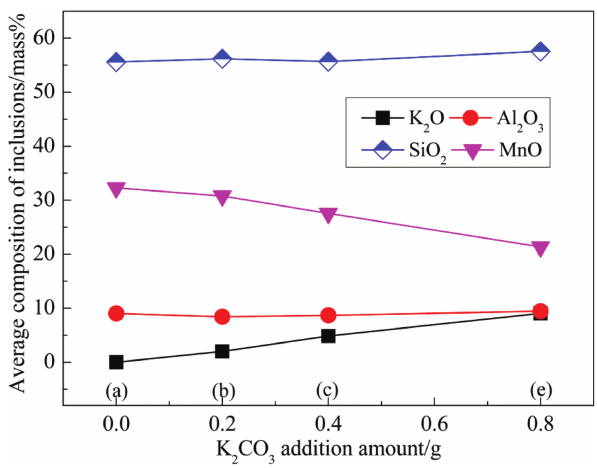
Figure 2: Effect of K 2 CO 3 addition amount on compositions of inclusions.